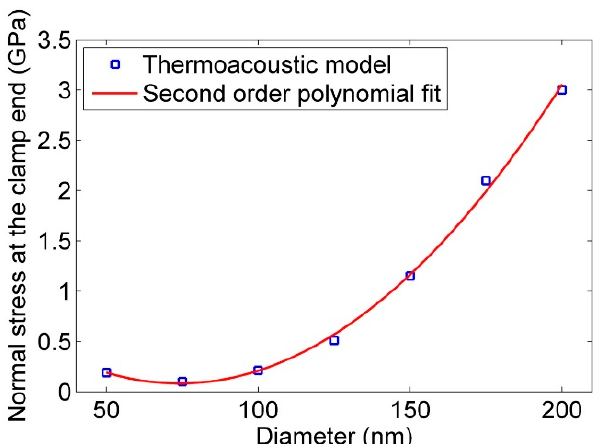
Figure 7. Effect of diameter on the normal stress at the clamp end of nanowire. Theoretical model suggested a linear fit while the thermoacoustic model shows a second-order polynomial fit for the relationship of diameter and normal stress at the clamp end.